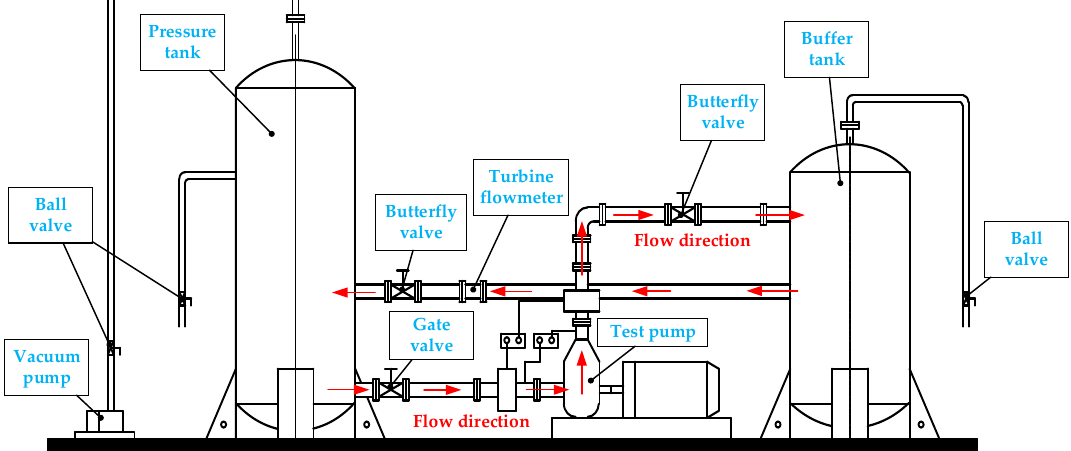
Table 1. Primary parameters of the centrifugal pump.